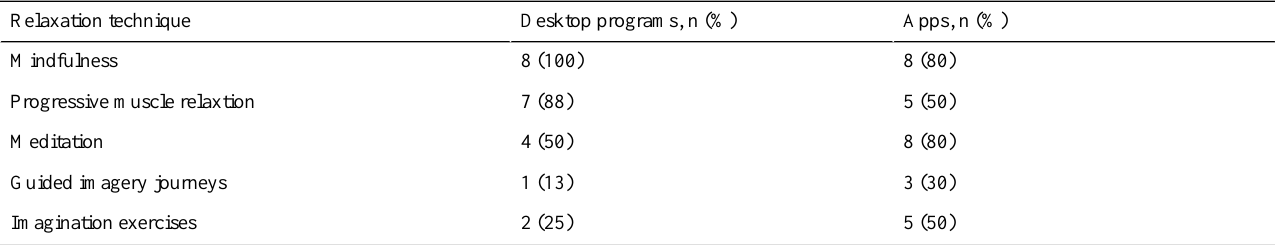
Table 8. Absolute numbers and relative share of relaxation techniques suggested in web-based interventions for desktop programs (N=8) and apps (N=10).